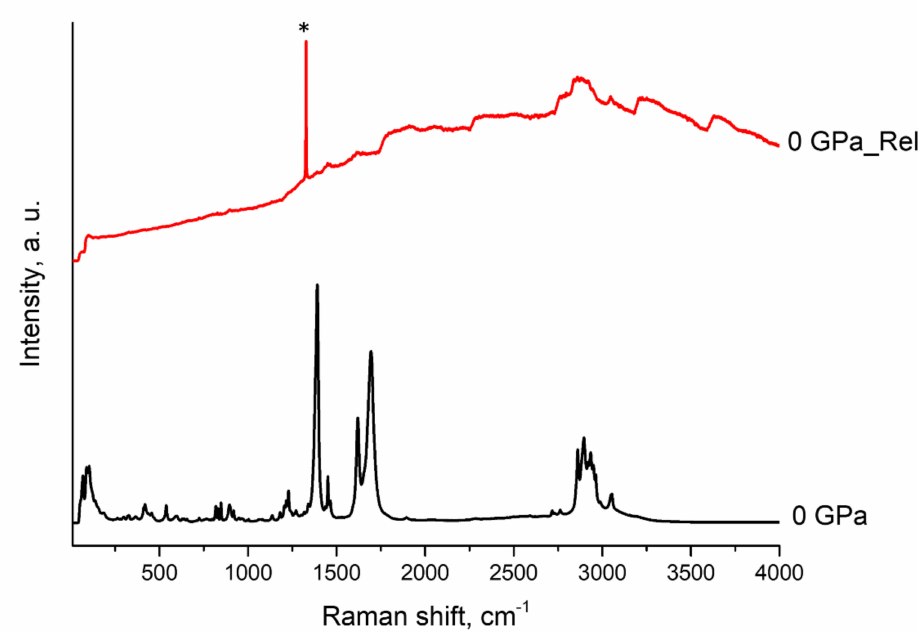
Figure 6. Raman spectra of LLHM at PIP PTM at 0 GPa before (bottom black line) and after (upper red line) pressure impact. * Asterisk mark the signal from DAC.